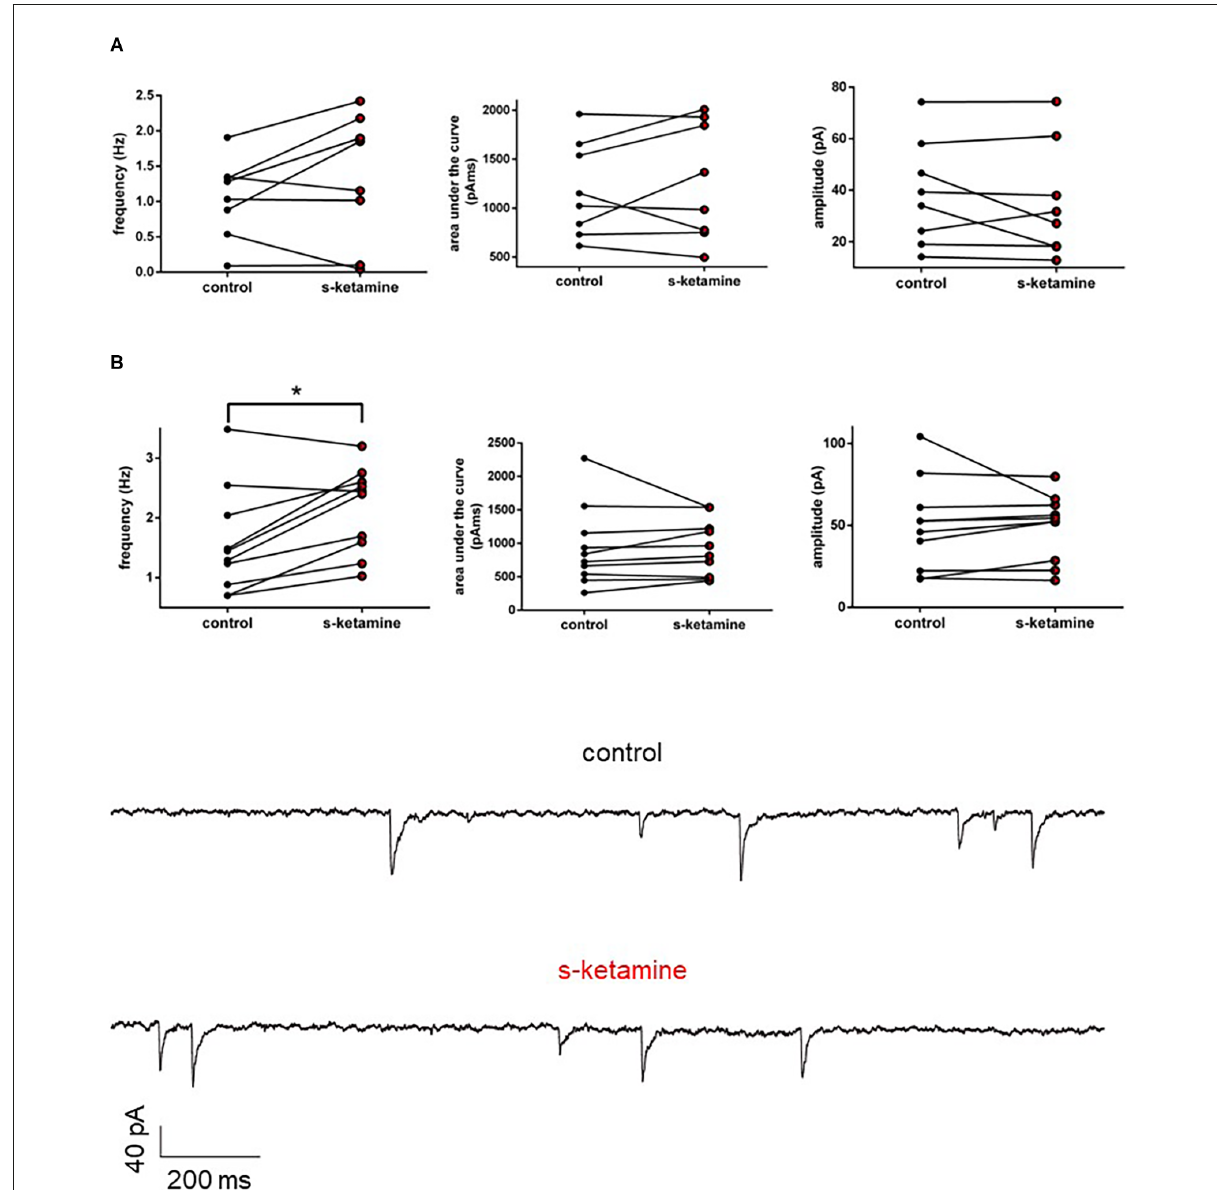
FIGURE7 (A) s-ketamine had no significant influence to the frequency ( p = 0.250), AUC ( p = 0.844) or amplitude ( p = 0.461) of NMDA-receptor dependent GABA A slPSCs (recordings without AP-5). (B) s-ketamine led to a marginal (0.5 Hz), but significant (*) difference of the frequency ( p = 0.001) of NMDA-receptor independent GABA A slPSCs (recordings with AP-5). The effect size of Cohen’s U3_1 was 0.8 (0.5 1). Besides of that, s-ketamine had no significant influence to the AUC ( p = 0.275) or the amplitude ( p = 0.375) of NMDA-receptor independent GABA A slPSCs. Representative traces are depicted